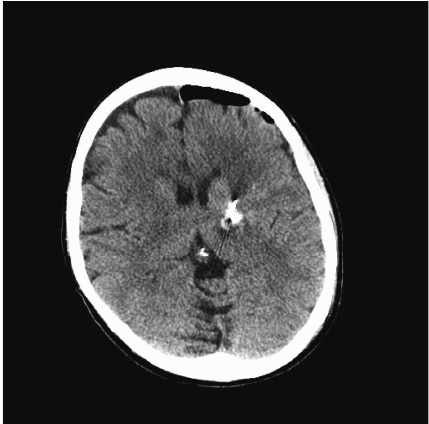
Figure 1: CT head demonstrated a small hemorrhage at the tip of the